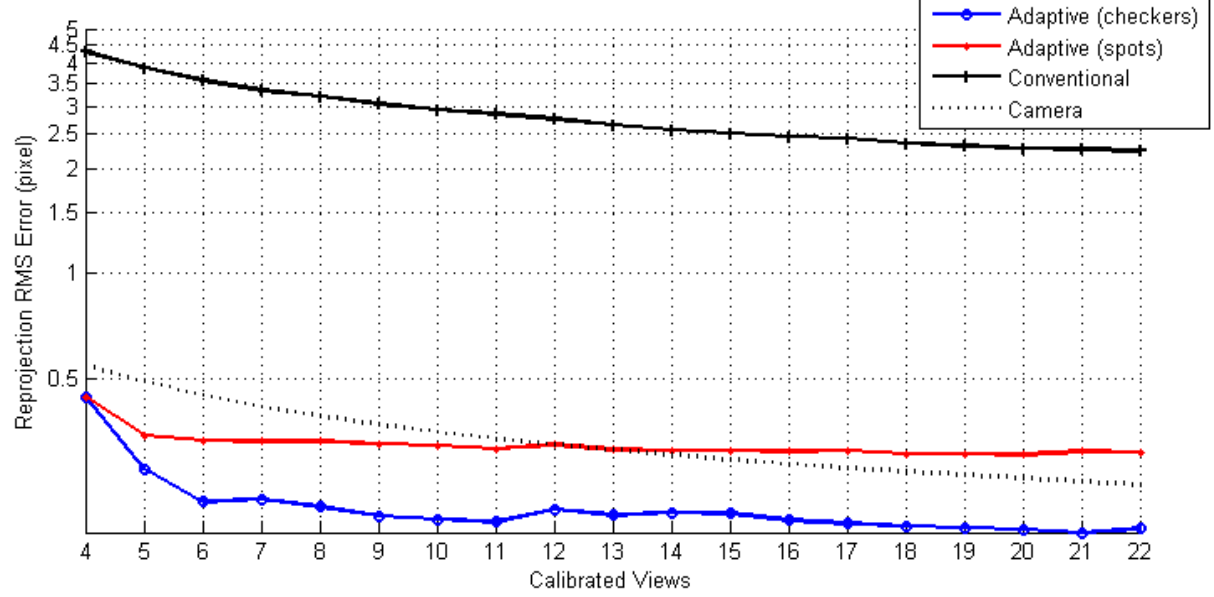
Figure 8. History RMS of reprojection errors during the calibration